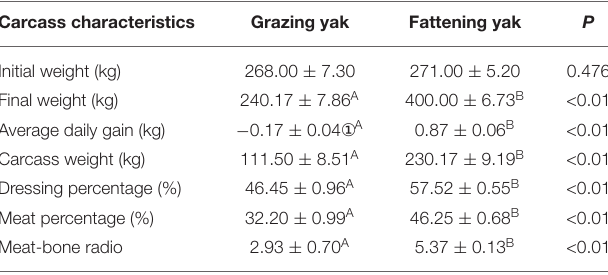
TABLE 3 | Effects of the intensive fattening with TMR on meat quality in longissimus dorsi muscle of yaks ( ¯ x ± s, %). Meat quality Grazing